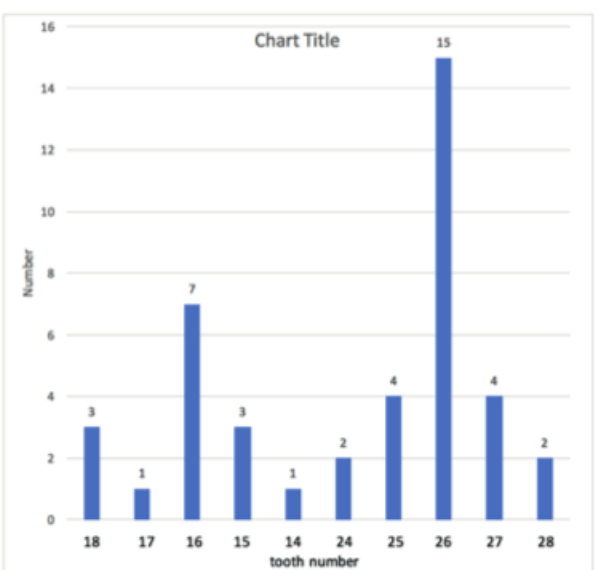
Figure 1. The 37 patients treated for odontogenic sinusitis according to